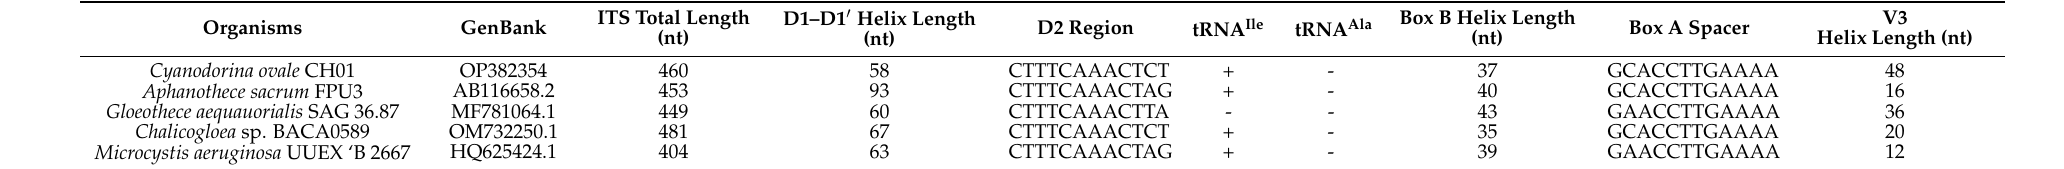
Table 2. Analyses of the ITS of the 16S–23S region for Cyanodorina ovale CH01 and other related